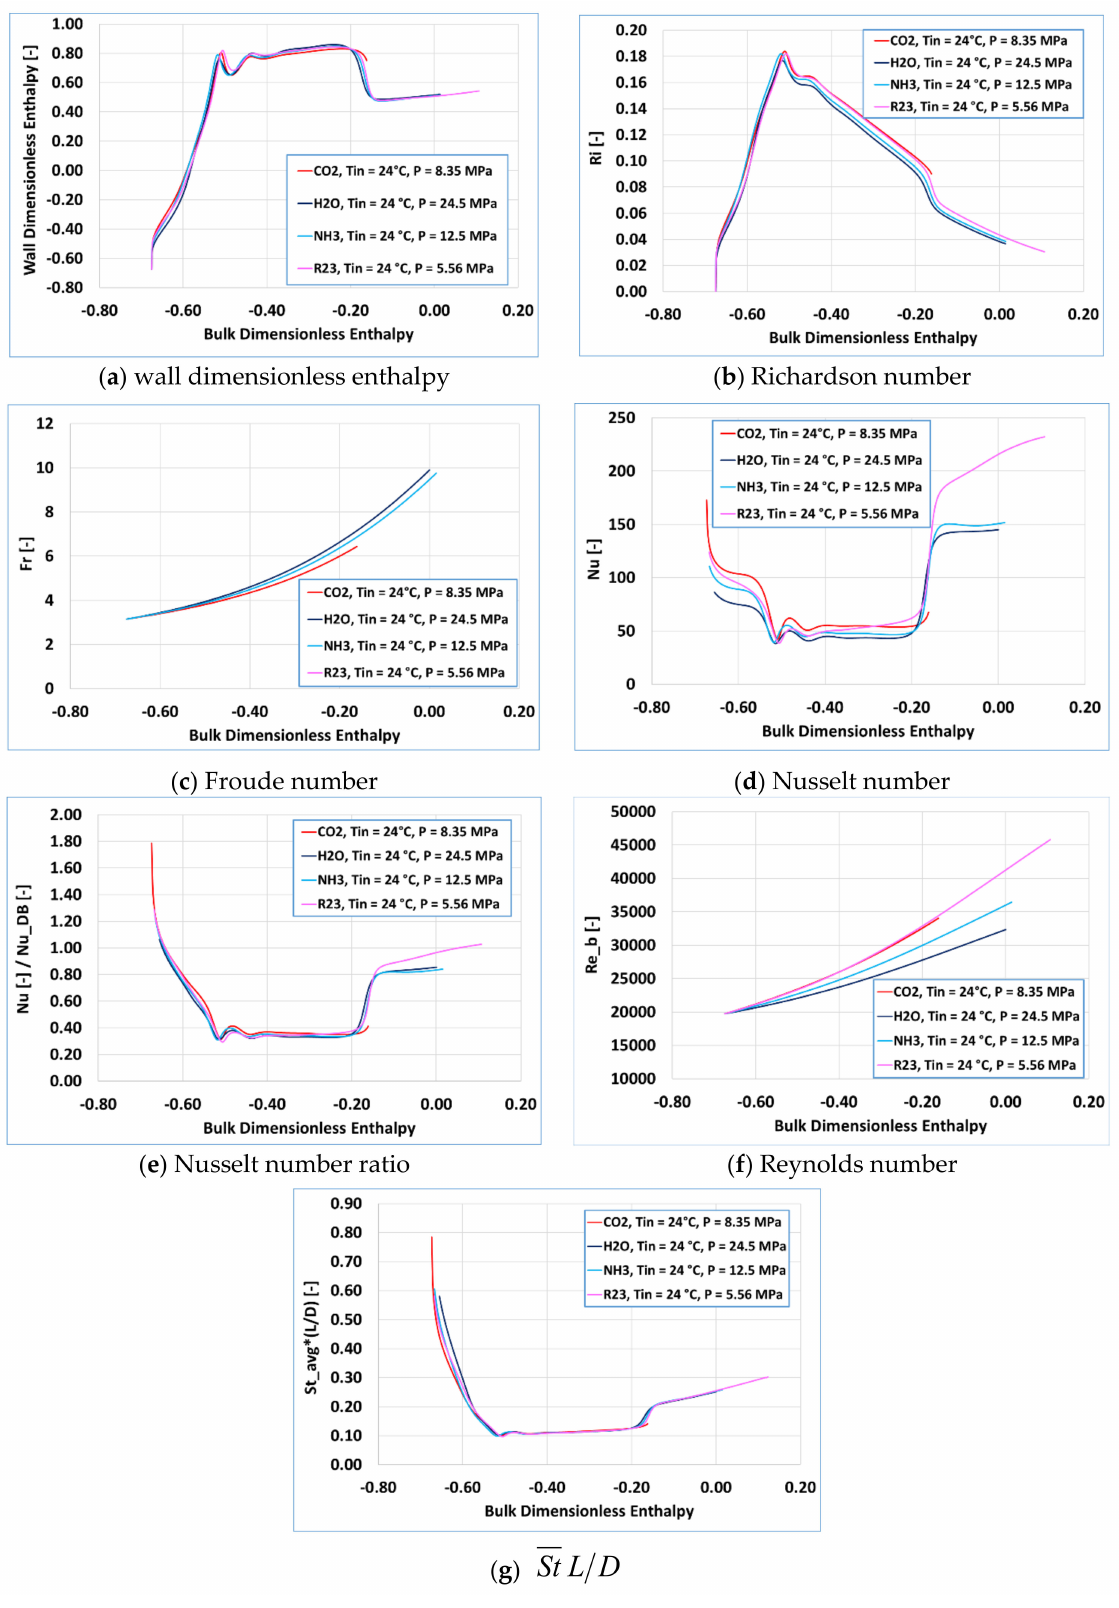
Figure 8. Trends of the relevant dimensionless numbers along the channel showing similarity for the case of Kline’s data with q (cid:48)(cid:48) = 18 kW/m 2 and T in = 24 ◦